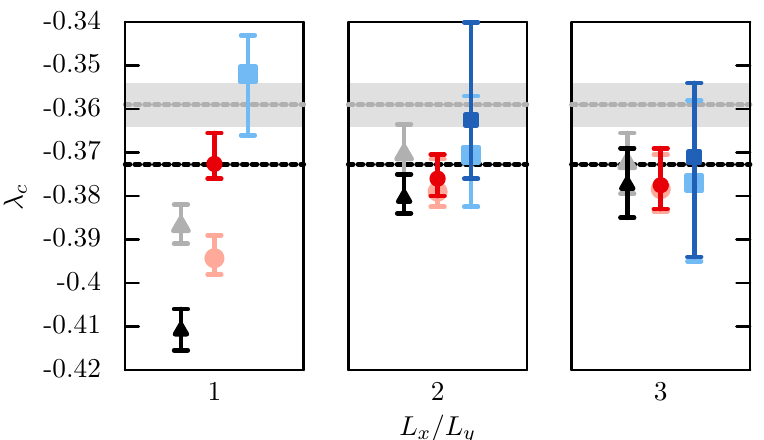
Figure 6: Finite-size scaling results for the transition point λ , from Néel and RVBS c order parameters (red circles: O , blue squares: O ; dark red / blue: spin within RVBS Néel distance b = 2 to the open boundary have been excluded) and flippability (grey trian- gles: O , black triangles: O ). Error bars are due to simulation precisions (i.e. flipp flipp2nd ∈ { 6,8,10 } , finite bond-dimension). System sizes have been scaled up to widths L y / L ∈ { 1,2,3 } . Dashed lines indicate the results held at three fixed aspect ratios L x y from [ 29 ] (grey with uncertainty) and [ 28 ]